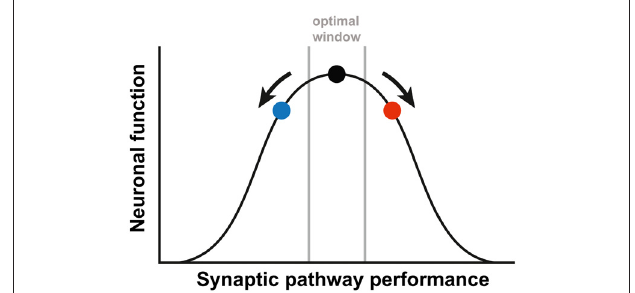
FIGURE 2 | A simplified depiction of the relationship between the synaptic pathway performance and the neuronal function. The black dot represents the optimal function, as is the case in WT animals. Either increased (red dot) or decreased (blue dot) performance leads to a suboptimal function of the neuronal synapses. In order to correct FXS, therapy needs to be fine-tuned, to prevent an overshoot (going from the red to the blue dot) or a worsening of the synaptic pathway performance (going from the red dot further to the right). The figure is based on the article by Auerbach et al.